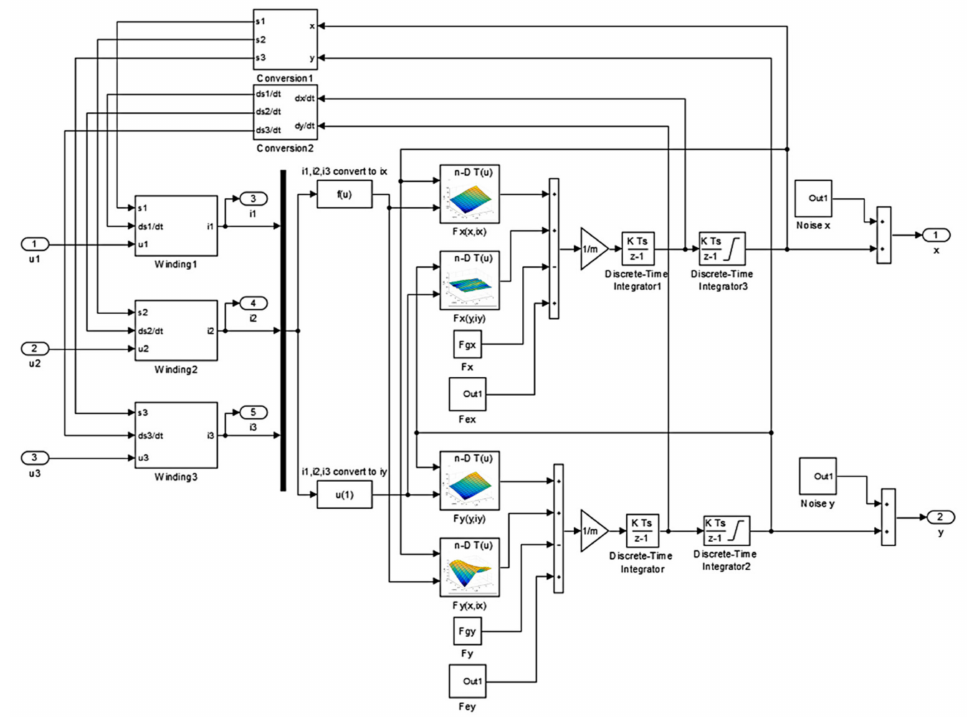
Figure 5. Implementation of the field-circuit indirectly coupled finite element